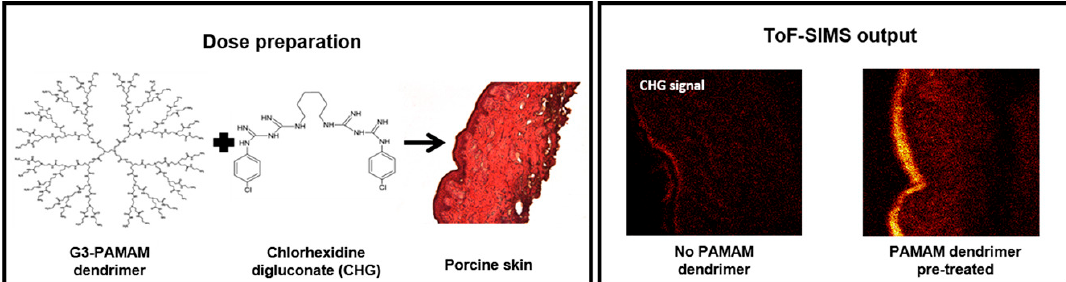
Figure 7. Dendrimer-based pre-treatment enhances the skin permeation of chlorhexidine digluconate. Reprinted from Holmes et al. [68] with permission from Elsevier. Copyright (2017) Elsevier B.V.